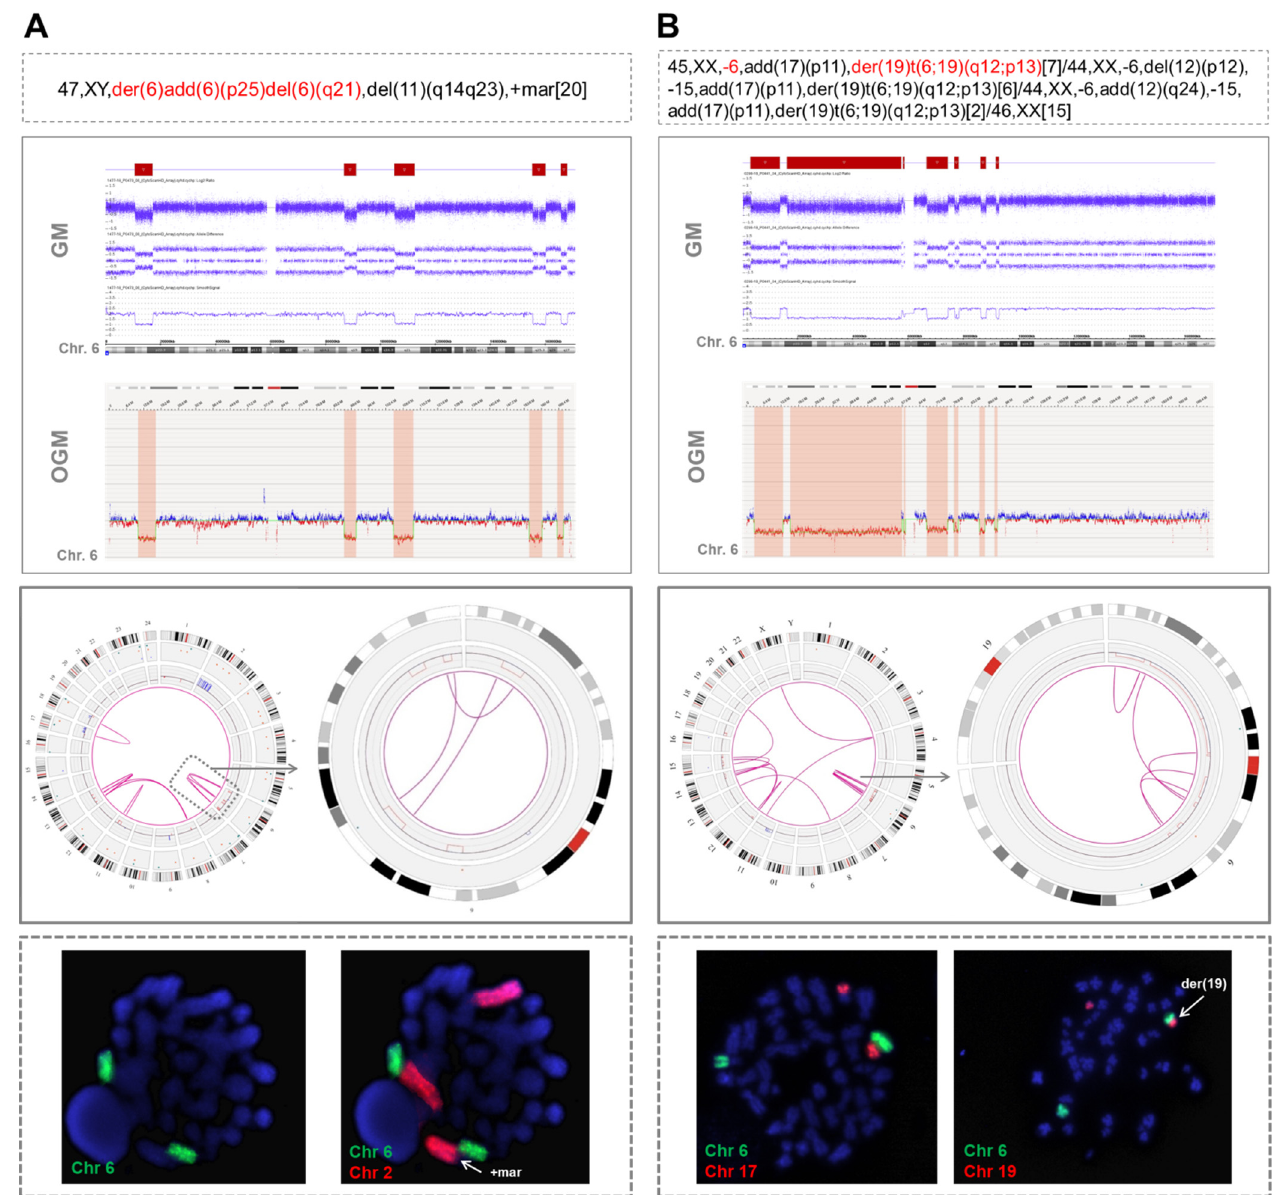
Figure 1. Two examples of cases analyzed by optical genome mapping showing only intra-chromosomal chromothripsis-related rearrangements. ( A ) A patient with chromothripsis in chromosome 6 in which OGM showed the presence of three intra-chromosomal translocations (case #9). When whole chromosome FISH painting (WCP) was performed, two green signals corresponding to chro- mosome 6 were observed, confirming the presence of material from this chromosome in the one initially reported as “der(6)add(6)(p25)del(6)(q21)” and in its normal counterpart. To ensure that this metaphase was abnormal, chromosome 2 was also stained, since both GM and OGM detected a duplication of 2p. WCP confirmed that the duplicated 2p was the marker chromosome found by CBA. ( B ) Patient with chromothripsis in chromosome 6 in which CBA identified a monosomy 6 and an unbalanced t(6;19)(q12;p13) (case #8). OGM revealed some rearrangements clustered in chromo- some 6, but it did not detect this translocation. It was probably not called by OGM due to the in- volvement of the telomeric region of chromosome 19, a highly repetitive region in which the OGM detection of structural variants is known to be limited. The hybridization pattern obtained by WCP confirmed the presence of this translocation, since two different signals (orange and green), corre- sponding to both chromosomes, could be observed together but without showing a mixing of these signals, which suggests that they rearranged after the process underlying chromothripsis. The ab- normalities detected by CBA in chromosomes with chromothripsis are highlighted in red in the karyotype. Chromosome views show the comparison of the CNA profiles identified by GM and